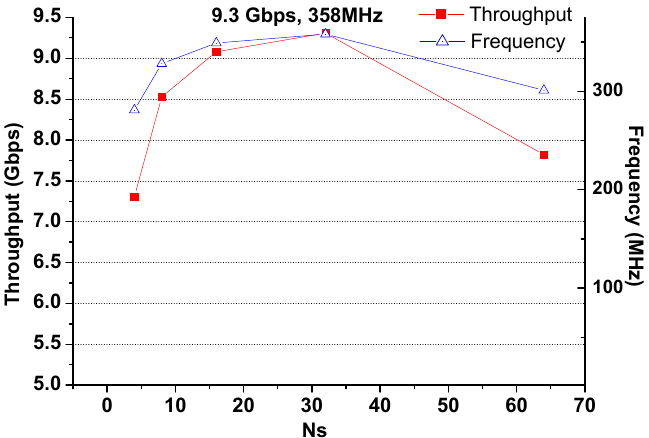
Figure 11. Throughput and working frequency of SAPTM with different N s